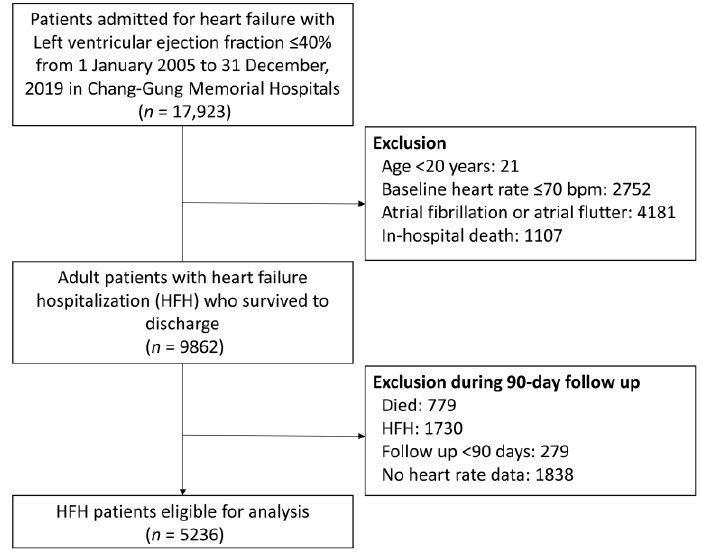
Figure 1. Flowchart of patient inclusion and exclusion.